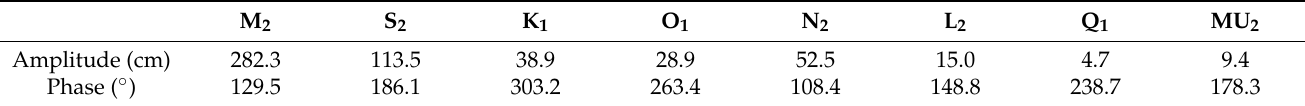
Table 1. Observed harmonic constants in 2019 at the Incheon tidal